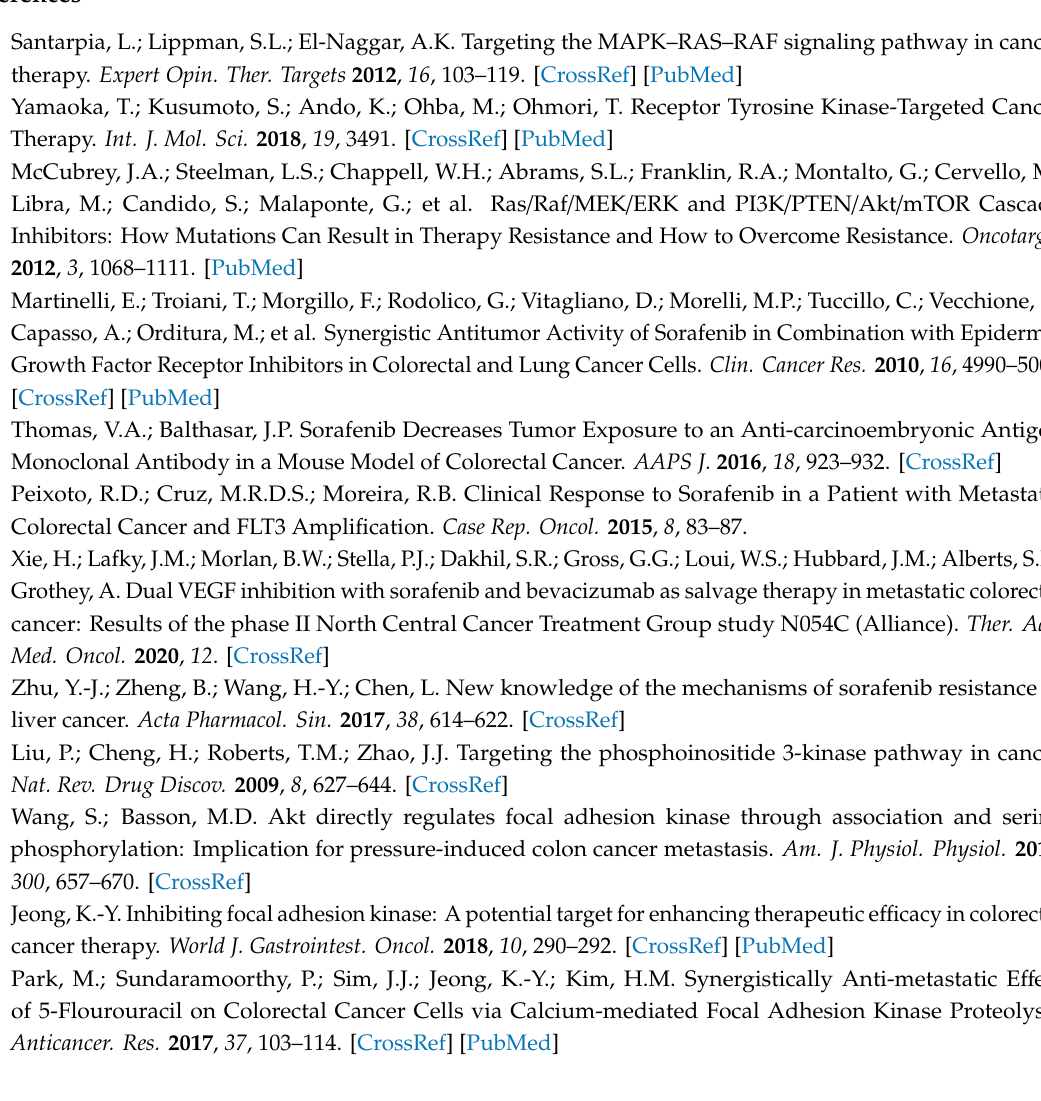
wound healing assay, Figure S2: Cell morphology following sorafenib treatment in colorectal cancer (CRC) cells, Figure S3: Cell morphology following lactate calcium salt (CaLa) treatment in colorectal cancer cells, Figure S4: Cell morphology following combination treatment in colorectal cancer (CRC)